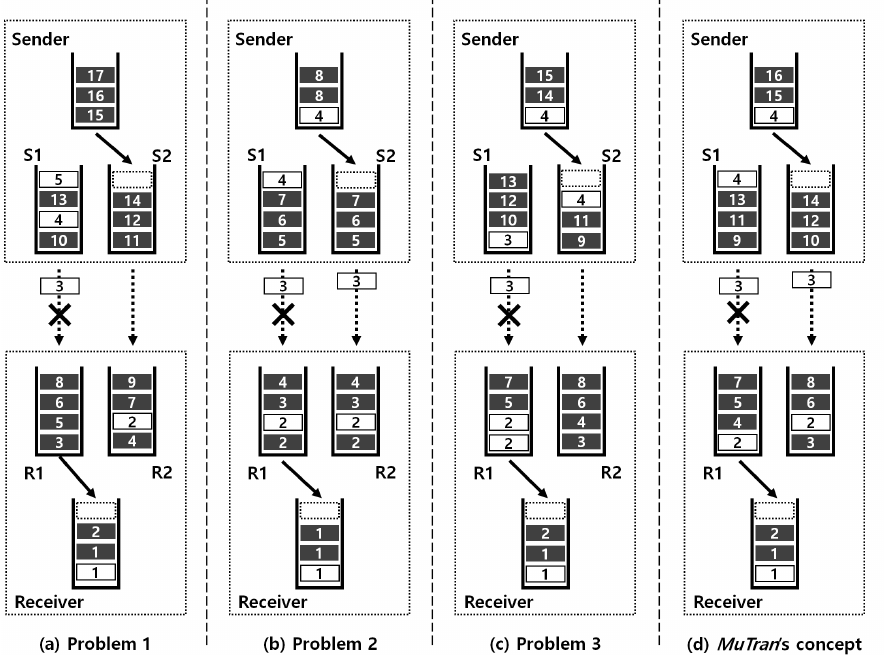
Figure 1. The packet transmissions of various cases. (This figure is drawn to distinctly present the difference between cases, so the ratio of control packets to data packets is